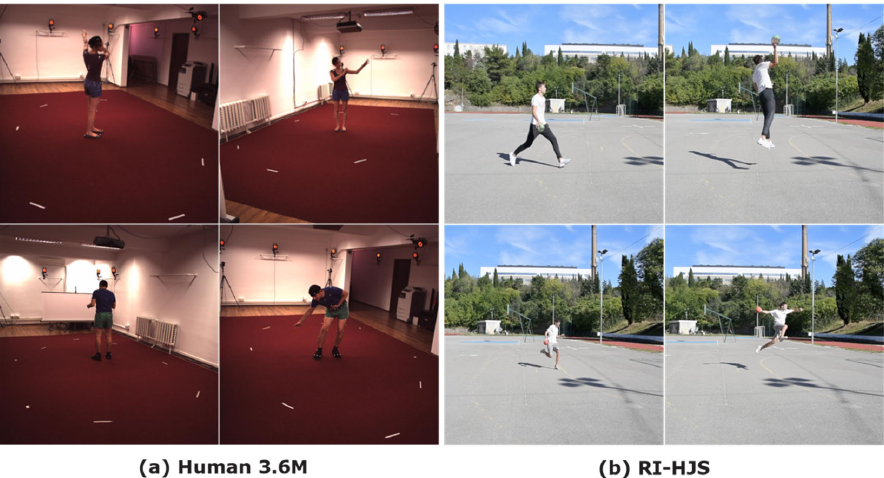
Figure 8. Examples from the Human3.6 dataset ( a ) and the RI ‐ HJS dataset ( b ) for 3D pose estimation.